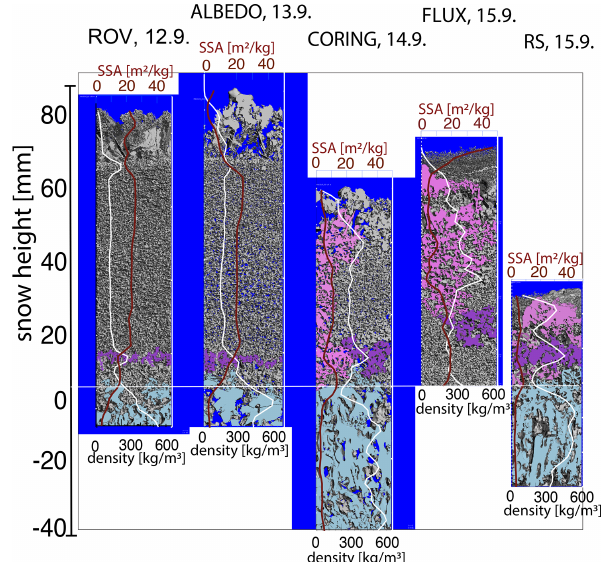
Figure 4. Micro-CT images of the snowpack before, during, and af- ter the rain on snow, together with micro-CT-derived ρ snow (white line) and SSA (dark-red line) profiles from which depth-averaged values are calculated (e.g., bulk density and SSA). The samples were taken at the following locations: ROV, ALBEDO, CORING, FLUX. To illustrate the changes in the snowpack and changes in the SSL thickness in this figure, the bottom of the snowpack is rep- resented by 0 (horizontal white line). Above 0 is snow, and below is surface scattering layer (SSL), marked in light blue. Pink marks the water percolation paths, and purple marks the dense layer that causes water pooling after the